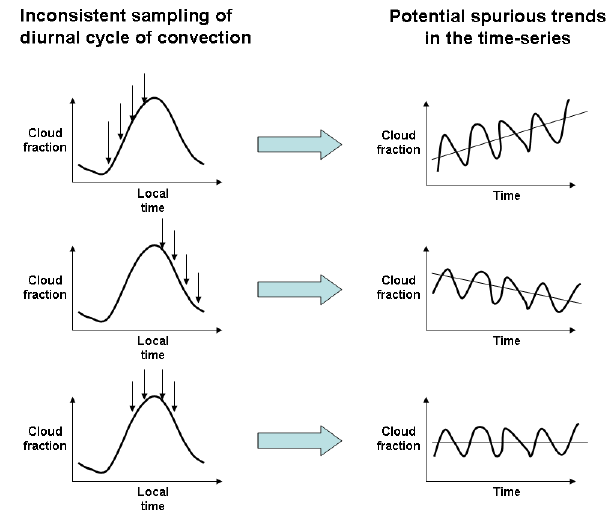
Fig. 2. Conceptual schematic of the potential impact of inconsistent time sampling due to orbital drift and an idealised diurnal cycle of convection on the time-series of convective cloud fraction (refer text for the description).